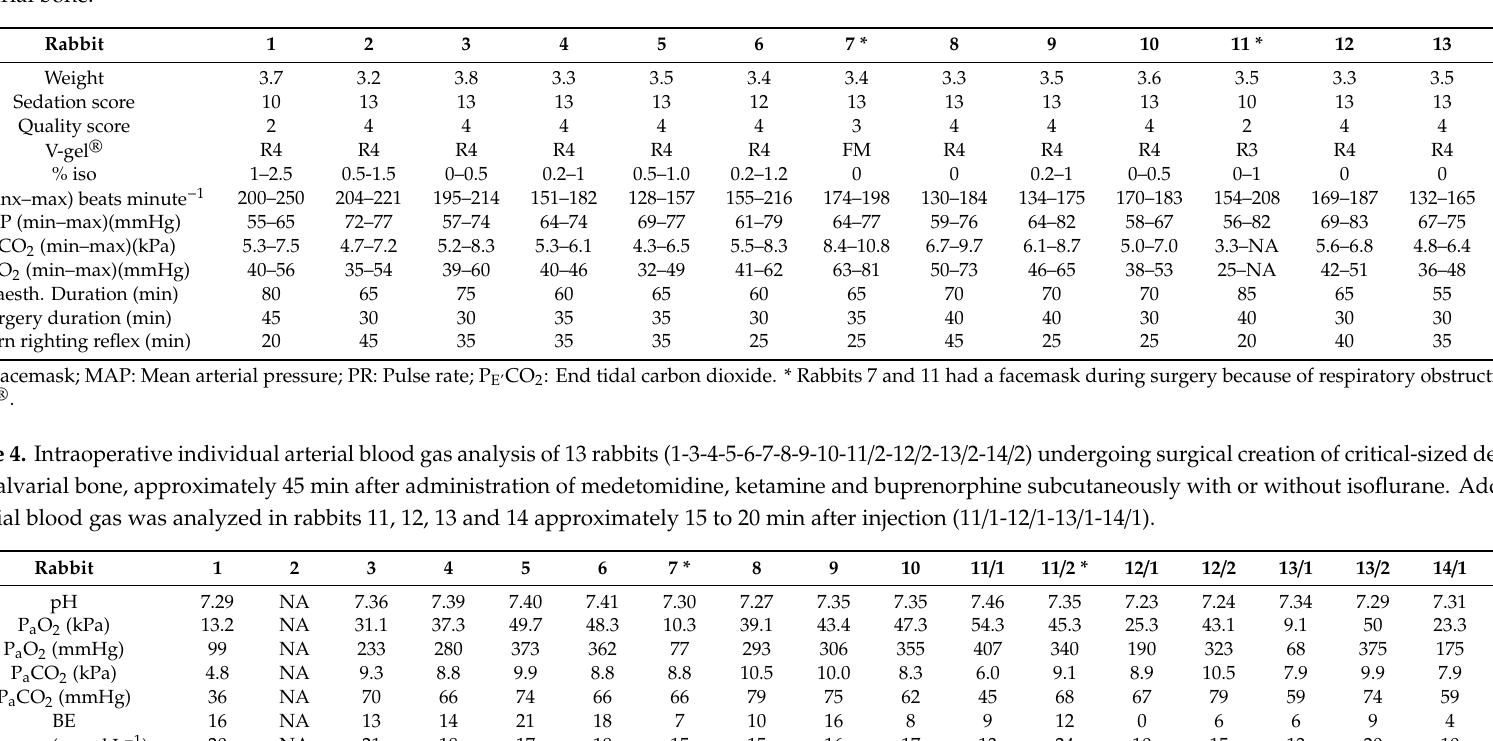
Table 3. Individual preoperative weight, sedation scores, quality score of induction and V-gel ® insertion, pulse rate, mean arterial pressure, end tidal carbon dioxide pressure, anaesthesia and surgery durations and return of righting reflex after anaesthesia in 14 rabbits undergoing surgical creation of critical-sized defects in the calvarial bone.